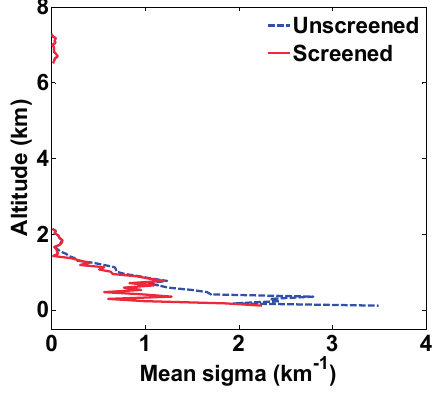
Figure 6. Information on aerosol extinction coefficient profile from CALIPSO at 02:19:48 (LZT) on 12 June 2012 (blue: without quality screening; red: with quality